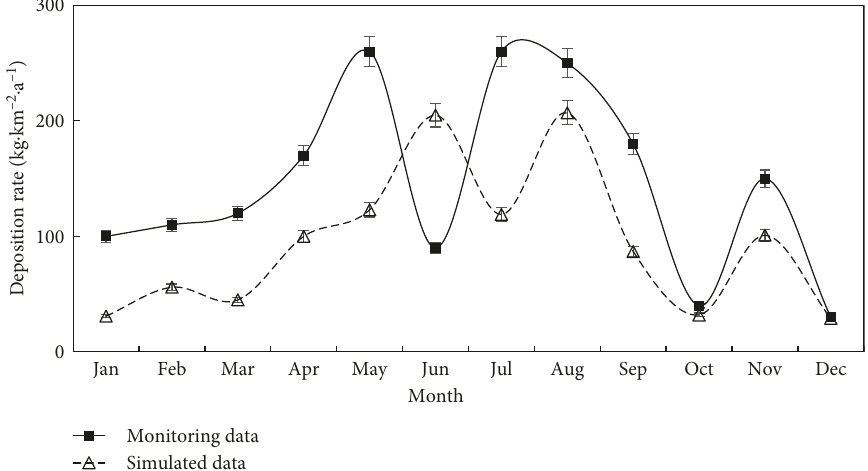
Figure 4: Monthly TN deposition (kg · N · km 2 · a − 1 ) in Nanjing and the simulated value for the Taihu